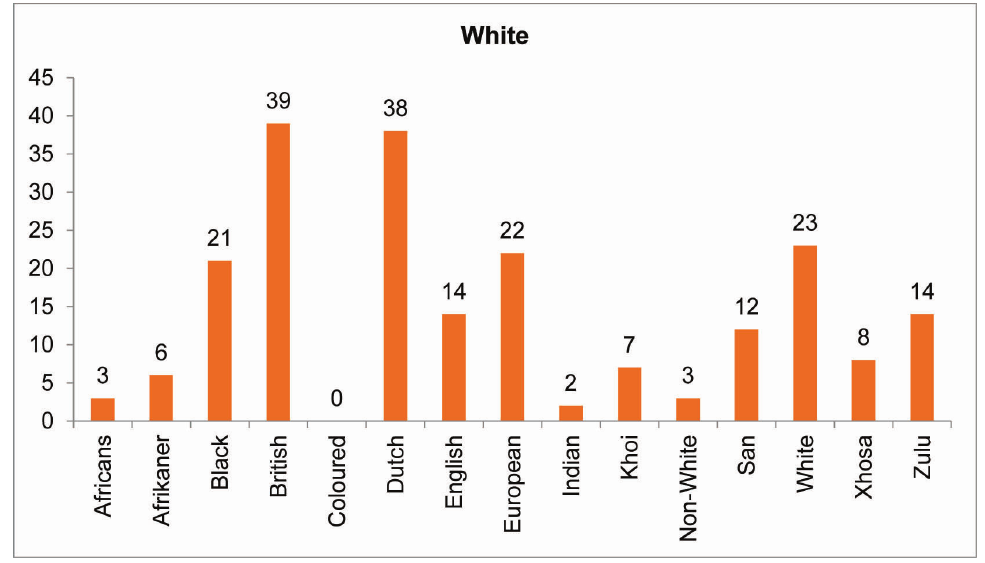
Figure 7: Races/ethnicgroupsmentionedmorethantentimesinwhitestudents’narrative